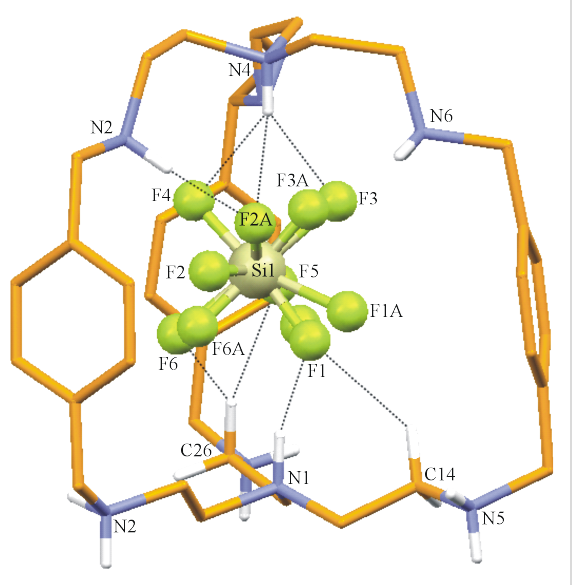
Figure 8: Mercury diagram depicting the encapsulation of the disordered HSiF 6− inside the [H 8 L 1 ] 8+ moiety along with various hydrogen bonding interactions. Only hydrogen atoms having interac- tions with encapsulated anion are shown for clarity.